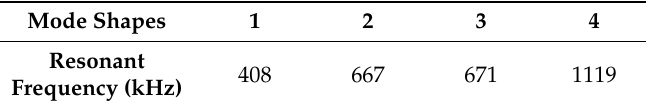
Figure 3. Mode simulation of HGMA structure ( a – d ) are 1st, 2nd, 3rd and 4th order modes.